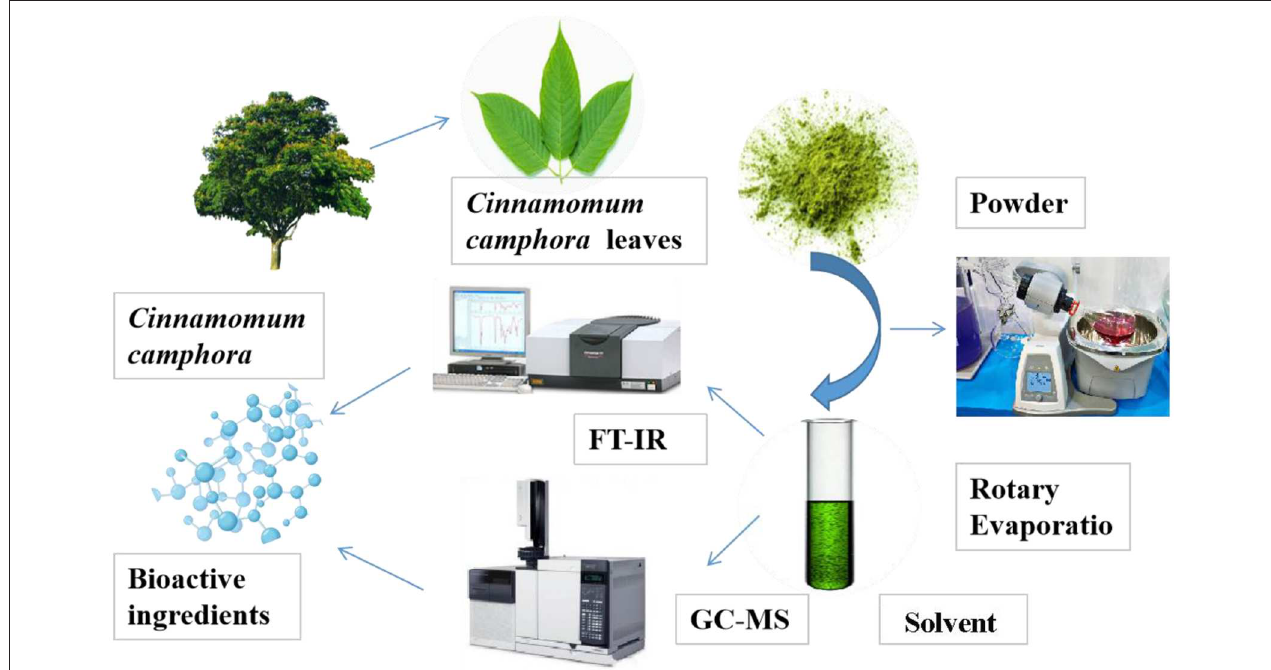
FIGURE 1 | The preparation process of C. camphora